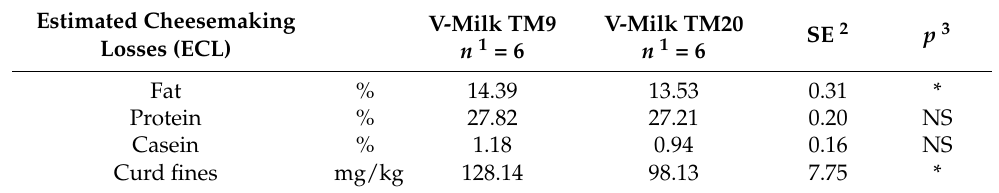
Table 3. Least square mean values of estimated cheesemaking losses (ECL) of vat milk (V-milk) obtained from the bulk milk kept at the farm at 9 ◦ C (TM9) and at 20 ◦ C (TM20). Estimated Cheesemaking V-Milk TM9 V-Milk TM20 SE 2 p 3 Losses (ECL) n 1 = 6 n 1 = 6 Fat % 14.39 13.53 0.31 * Protein % 27.82 27.21 0.20 NS Casein % 1.18 0.94 0.16 NS Curd fines mg/kg 128.14 98.13